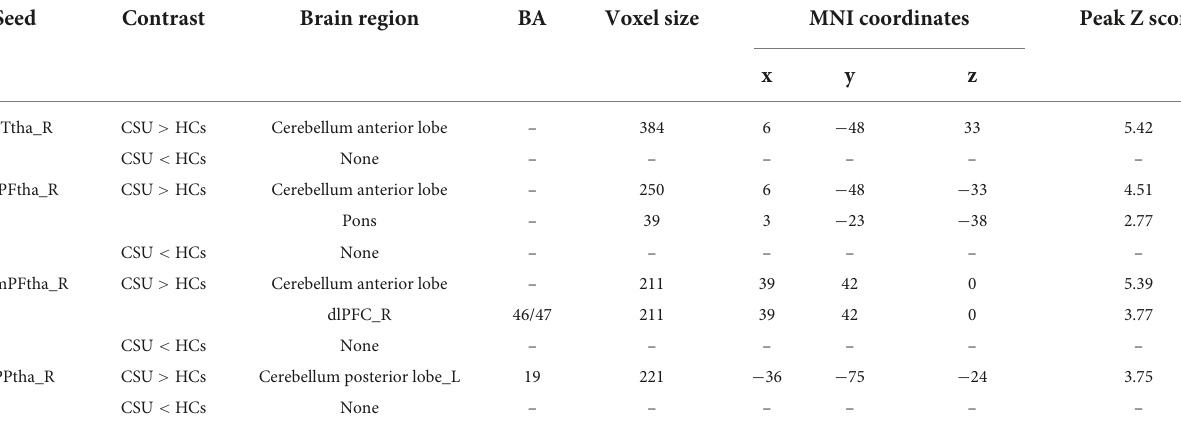
TABLE 3 Brain regions with increased seed-based rs-FC values in patients with CSU compared to HCs. Seed Contrast Brain region BA Voxel